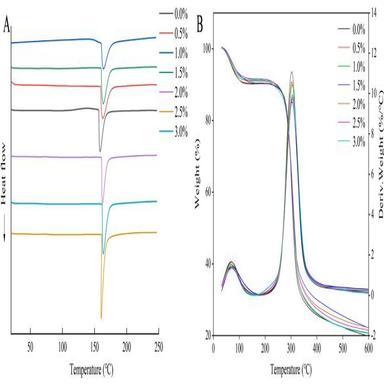
DSC, TGA and DTG curves of the cross-linked PPI/PUL NFs.